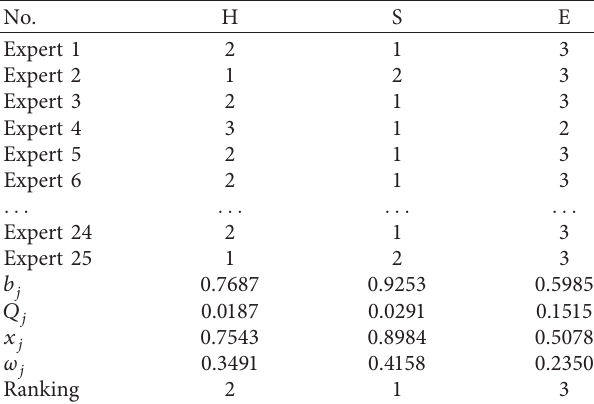
Table 4: The weights of primary indexes.